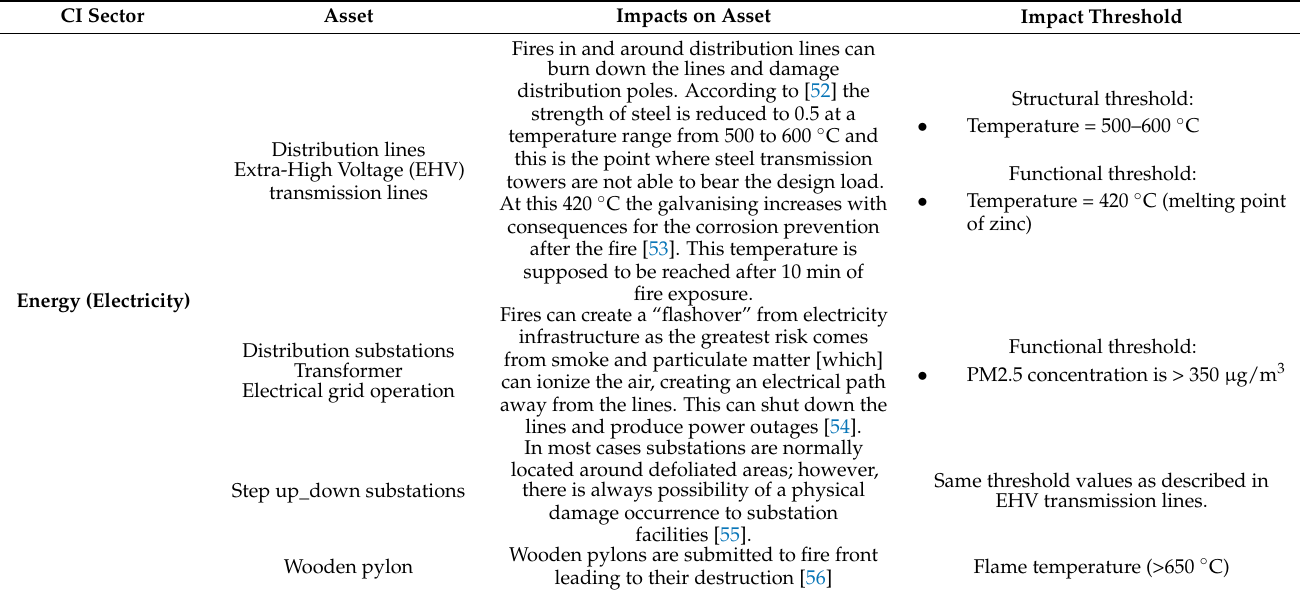
Table 1. Forest fires impact on electricity infrastructures and associated